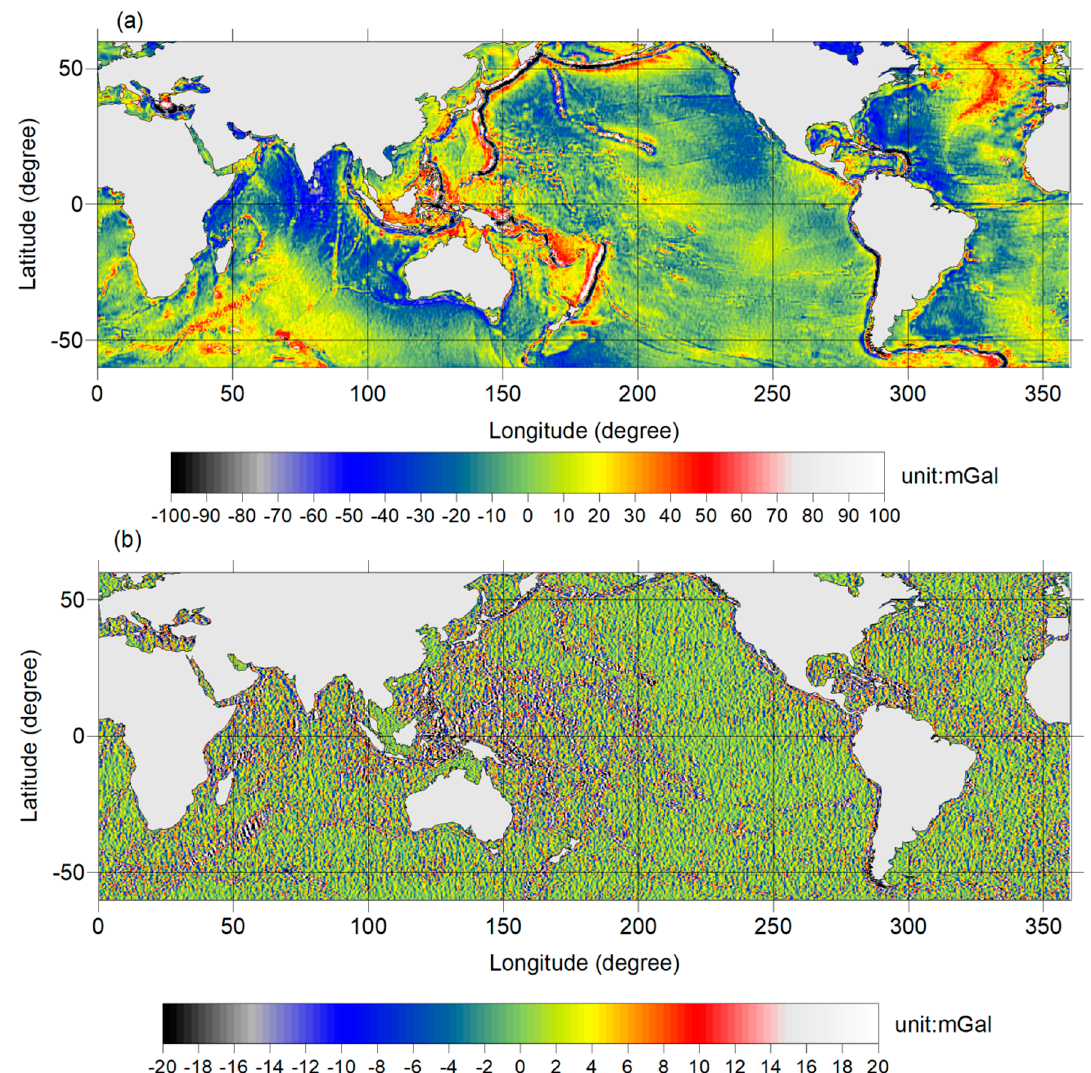
Figure 14. ( a ) HY-2A-derived gravity anomaly and ( b ) differences between the HY-2A-derived gravity anomaly and SIO. Table 4. Statistics about the magnitude of gravity anomaly errors.